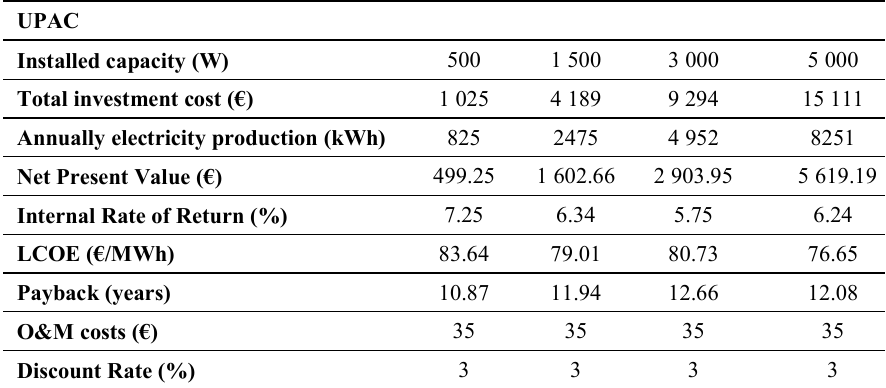
Table 2. Economic analysis of different UPAC